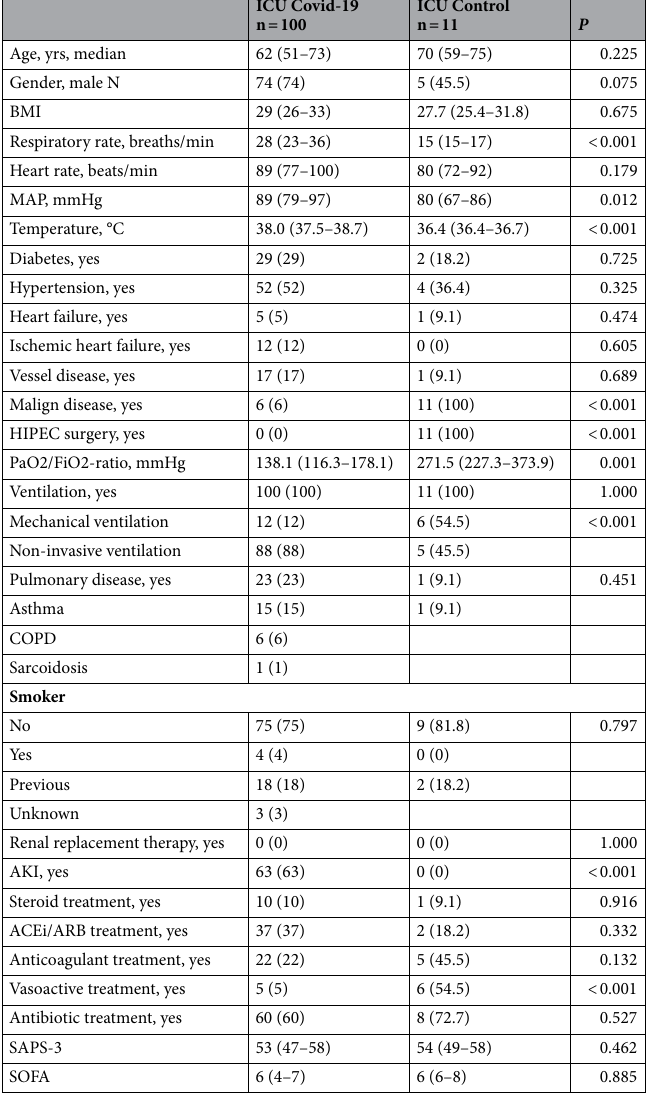
Table 1. Demographic and baseline characteristics of 111 patients on admission to the Intensive Care Unit. Values are represented as median (IQR) or n (%). The p-value is calculated for continuous parameters with the Mann–Whitney U test, and for categorical parameters the chi-square test; p < 0.05 is considered significant. BMI body mass index, MAP mean arterial pressure, HIPEC heated intraperitoneal chemotherapy, COPD chronic obstructive pulmonary disease, ACEi/ARB angiotensin-converting enzyme inhibitor/angiotensin receptor blockers, SAPS simplified acute physiology score, SOFA sequential organ failure